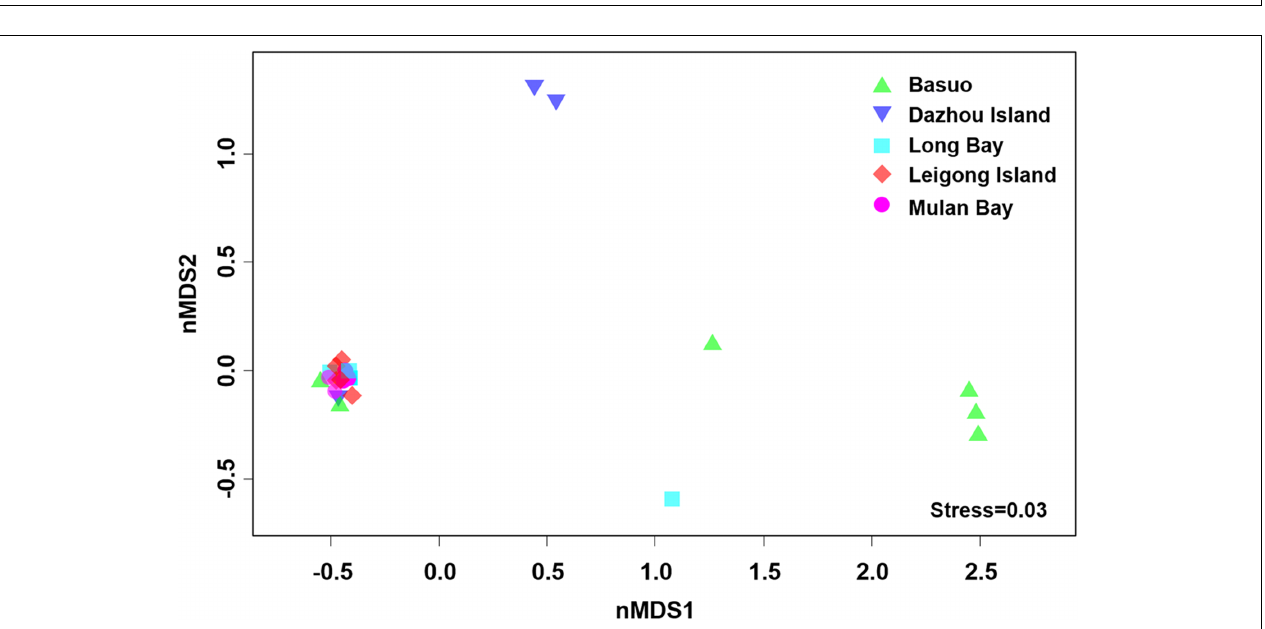
FIGURE 3 | Non-metric multidimensional scaling (nMDS) plotting of Symbiodinium communities using subclade data among locations. Axes do not represent any measured parameters, but define a 2-D space that allow the best spatial representation of sample similarity, based on Bray–Curtis similarity indices.